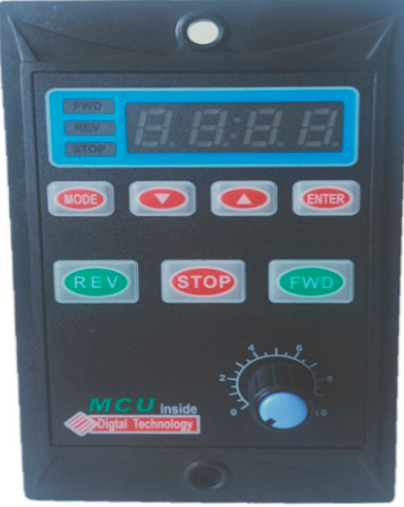
Figure 4. Photo of YVF-6314 adjustable motor. Figure 5. Photo of frequency modulator. Figure 5. Photo of frequency modulator.